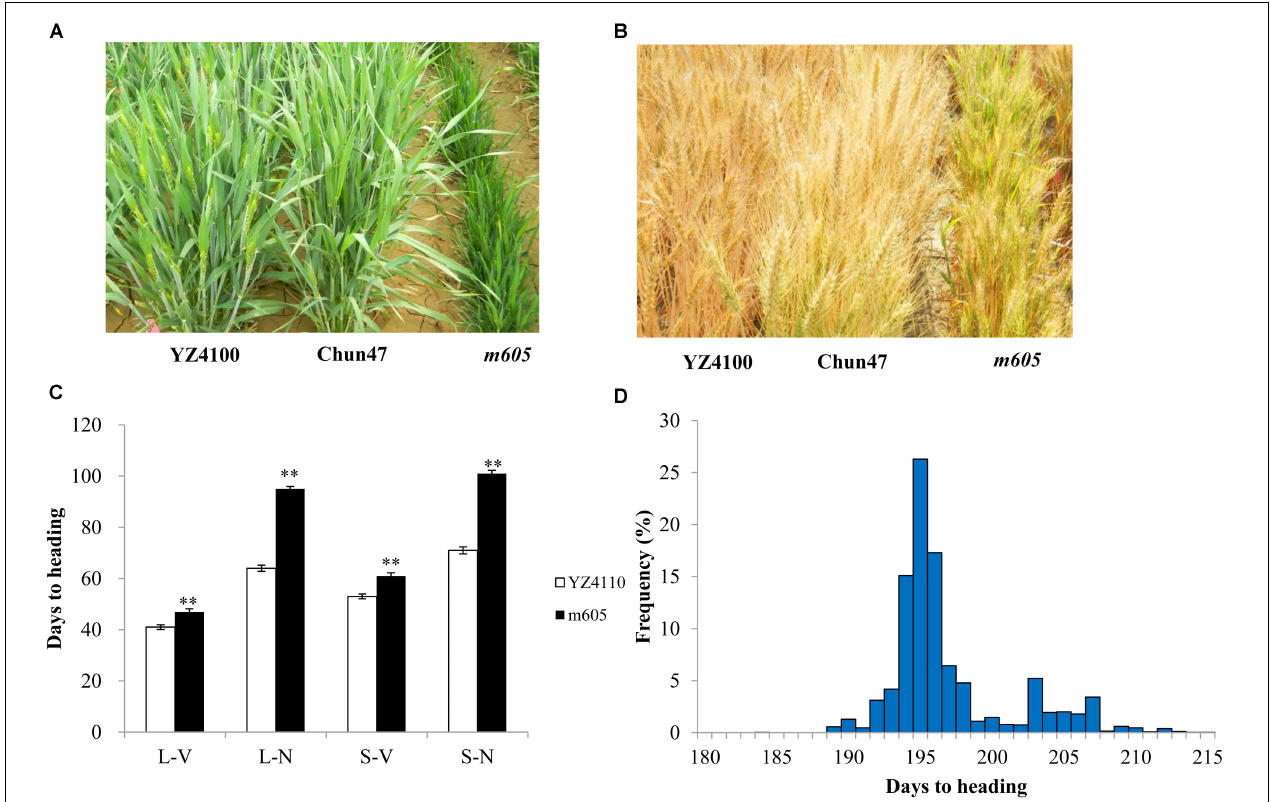
FIGURE 1 | Phenotypes of wild-type YZ4110, late heading mutant m605 and early heading parent Chun47 as planted in the field and in controlled conditions. (A) The phenotypes of YZ4110, Chun47, and m605 at the heading stage when planted in the field. (B) The phenotypes of YZ4110, Chun47, and m605 at the ripening stage when planted in the field. (C) Days to heading of YZ4110 and m605 under controlled conditions. L-V, long day and vernalized; L-N, long day and non-vernalized; S-V, short day and vernalized; S-N, short day and non-vernalized. The data in (C) represent the means of three replicates, and the error bars indicate the standard deviation. ∗ and ∗∗ represents 0.01 < p < 0.05 and p < 0.01, respectively, based on a Student’s t -test. (D) Frequency distribution of heading date in the F 2 population derived from Chun47 × m605 planted in Xinxiang, Henan